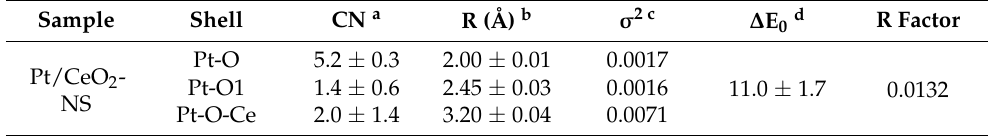
Figure 13. ( A ) Pt L 3 -edge XANES spectra and ( B ) R-space spectra from Pt L 3 -edge EXAFS data of Pt/CeO 2 -NS, Pt foil, and PtO 2 ; ( C ) Corresponding EXAFS fitting curve of Pt/CeO 2 -NS. Table 4. EXAFS fitting parameters at Pt L 3 -edge for Pt/CeO 2